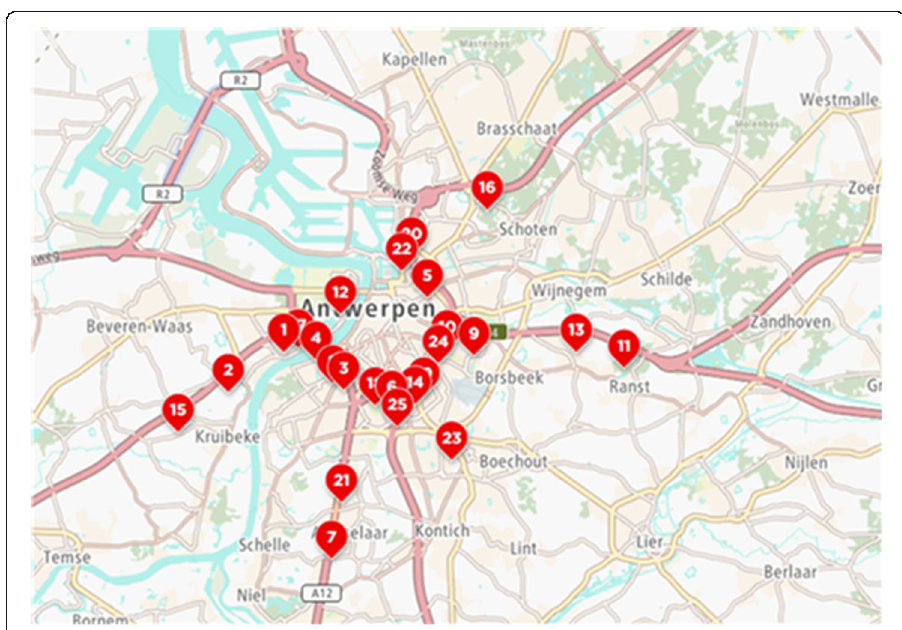
Fig. 4 Delay hotspots in Antwerp in 2016. (Source: TomTom